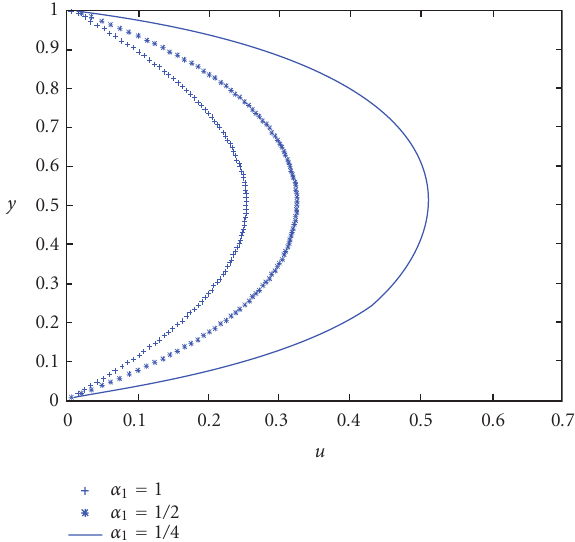
Figure 4.4. Velocity profiles for various values of α 1 and fixed α 2 = 1 (I: Wang et al. solution; K: our solution) for dp/dx = −